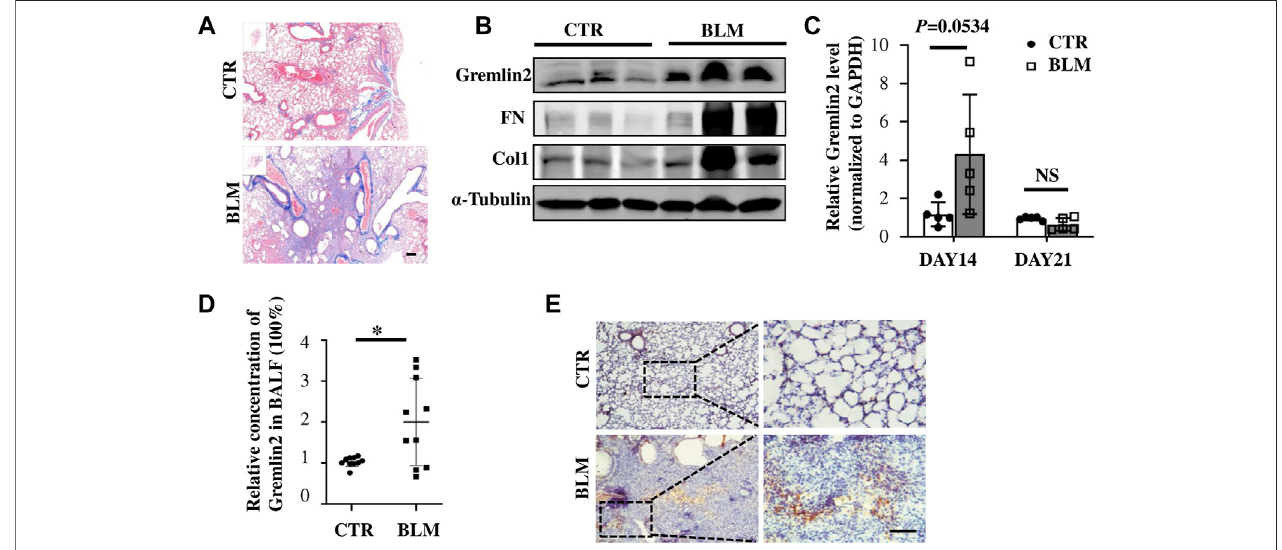
FIGURE3| Increased expression ofGremlin2 inthelung tissue ofbleomycin-induced pulmonary fi brosis mice (A) Masson ’ strichromestainingofthelung tissue in the bleomycin-treated mice and PBS-treated control mice. (B) 21 days after bleomycin (BLM) or PBS (CTR) treatment mice were sacri fi ced. Western blotting was performed using the lung tissue homogenates. α -tubulin was used as a reference collagen1 (Col1) and fi bronectin (FN) were detected as indicators of fi brosis, and Gremlin2(Grem2)wasusedasthetargetprotein. (C) Followingthesameoperationmethod as (B) ,thecorrespondingmRNAwasextracted fromthelungtissueof micetreatedfor14and21 days,andreal-time-quantitativePCRwasusedtodetectthemRNAexpression levelsofGremlin2.Day14CTR n (cid:2) 5,BLM n (cid:2) 5, p (cid:2) 0.0534, student ’ s paired t-test; day 21 CTR n (cid:2) 5, BLM n (cid:2) 5, NS p > 0.05, student ’ s paired t-test. (D) Expression level of Gremlin2 in alveolar lavage fl uid. CTR n (cid:2) 10, BLM n (cid:2) 10, * p (cid:2) 0.0102, student t paired test. (E) Representative images of control lung tissue sections (CTR) and fi brotic lung tissue (BLM) assessed using immunohistochemicalstainingwithanti-Gremlin2antibody.Therighttwopicturesare10xmagni fi